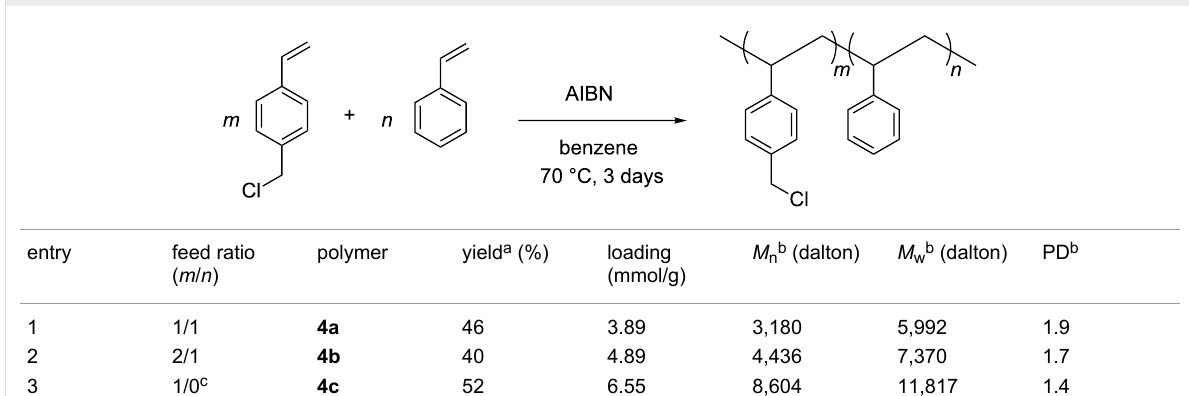
a Calculated on the base of the monomer feed ratio. b Determined by GPC relative to polystyrene standards. c